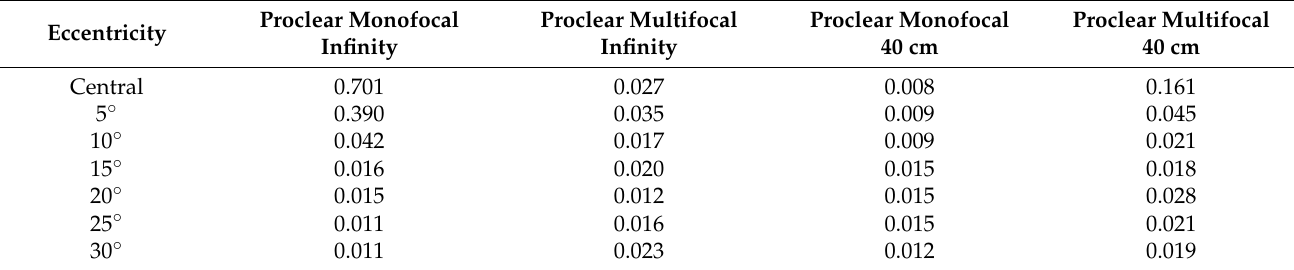
poral eccentricity are equal. eccentricity are